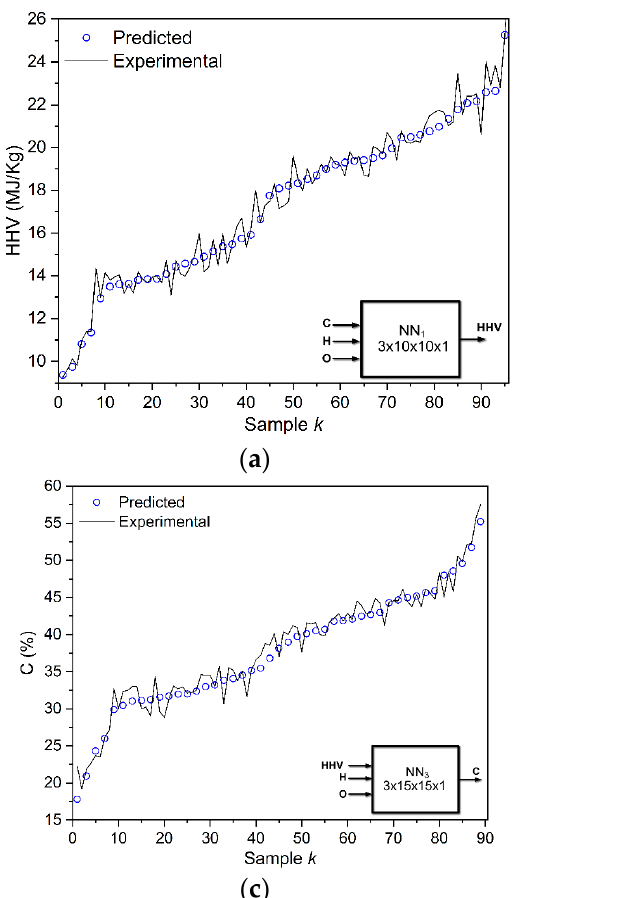
( a , b ), C te ( c ), H te ( d ) versus predicted HHV pr k k k